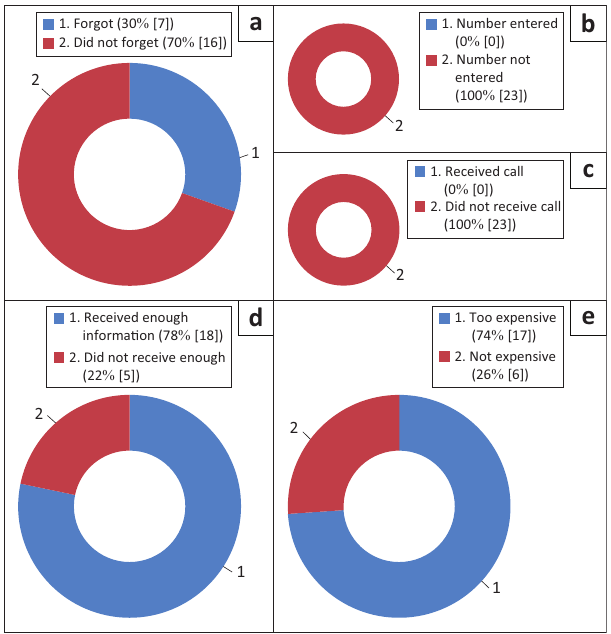
FIGURE 3: Percentage (and number) of non-attending patients who believed whether each factor contributed to their non-attendance: (a) forgetting to attend surgery, n = 23; (b) reminder phone number entered into patient phone, n = 23; (c) receiving reminder call, n = 23. (d) Informing patients adequately, n = 23. (e) Surgery expense, n = 23.